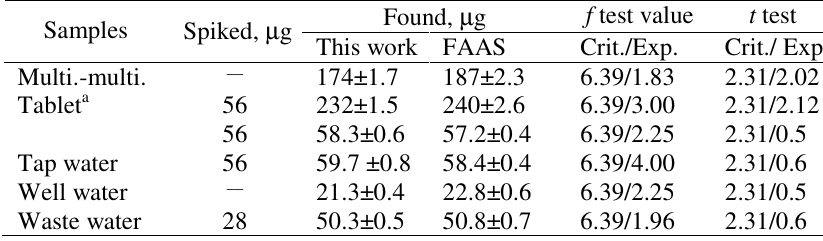
Table 3 . Comparison of the result obtained from this work with that of FAAS for the determination of Fe(III) in various environmental samples. The results are reported as the average values from five sample measurements with the related standard